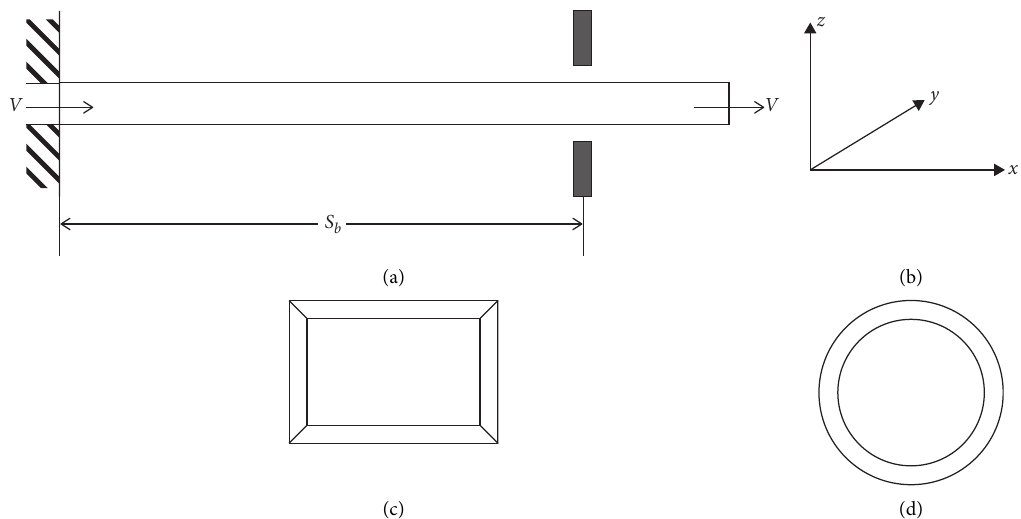
Figure 1: Schematic of a fluid-conveying microtube with one end free and subjected to motion